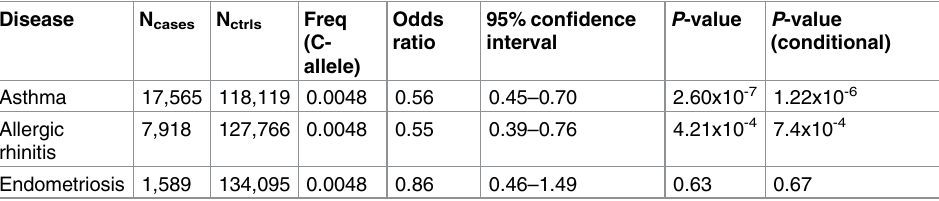
Table 3. Association between IL33 -rs146597587and asthma, allergic rhinitis, or endometriosis risk in the UK Biobank. All analyseswere corrected for age, sex, and the first 10 principalcomponents. The direc- tion of the odds ratio is for the rare allele(rs146597587, C-alleleon forward strand). The conditional P -values were calculatedin a logistic model accountingfor genotypes at common single nucleotidepolymorphisms (SNPs) previouslyassociatedwith asthma, allergicrhinitis, or endometriosis: rs343496,rs7032572, rs72699186, rs1342326,rs2381416, rs928413, rs10975519. Disease N cases N ctrls